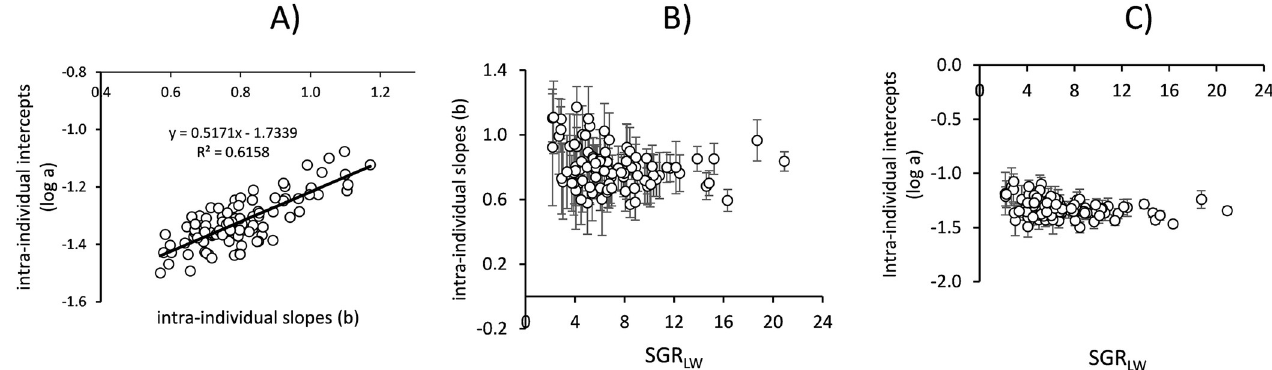
Fig 5. A) Relationship between proportionality constant ( log a ) and mass exponents ( b ) of individual allometric relationships of standard oxygen consumption and live weight. B) Mass-exponents b ( ± SD) and C) Proportionality constant, log a ( ± SD) of intra-individual allometric relationships of standard oxygen consumption and live weight plotted as a function of specific growth rate of live weight (SGR LW